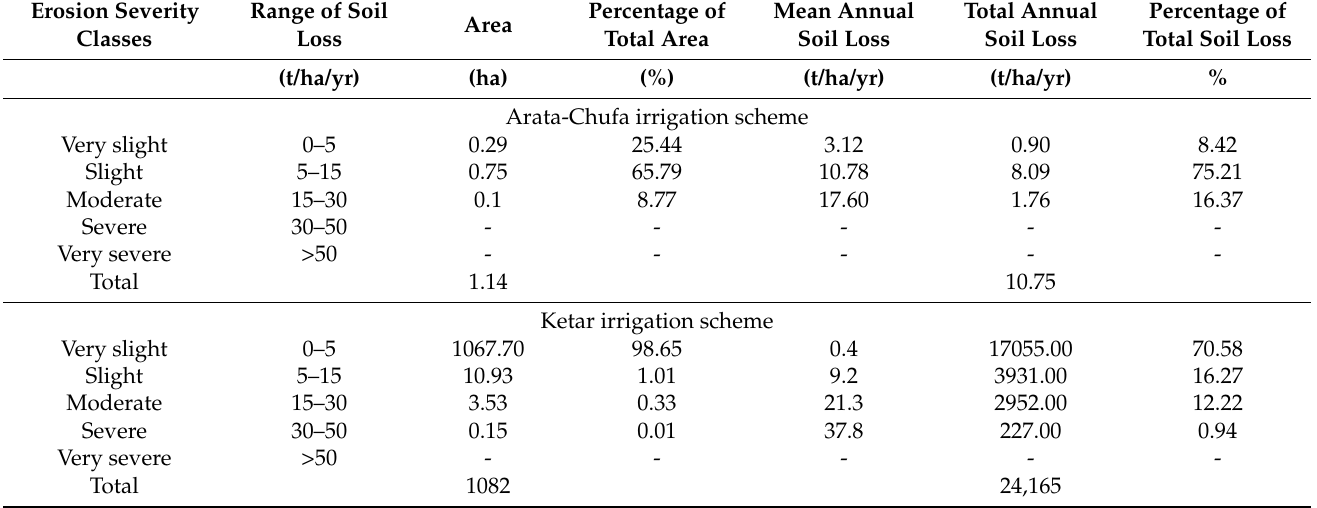
Table 4. Severity classes of soil erosion loss for the area contributing sediment to the main canal of the Arata-Chufa and Ketar irrigation schemes. The severity classes are adapted from